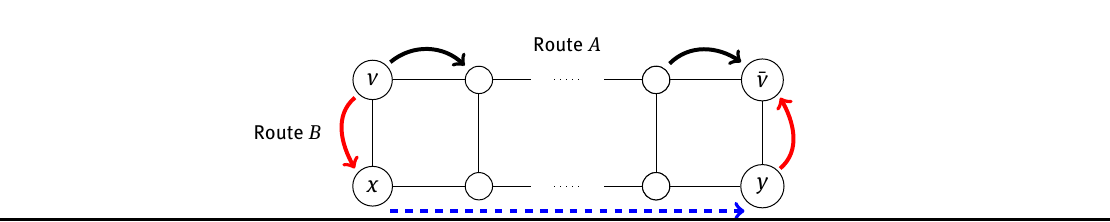
Figure 7: A ladder graph G . In the transportation of both W 1 and W h , the weights of the lower row are transported along the lower path (a blue dotted